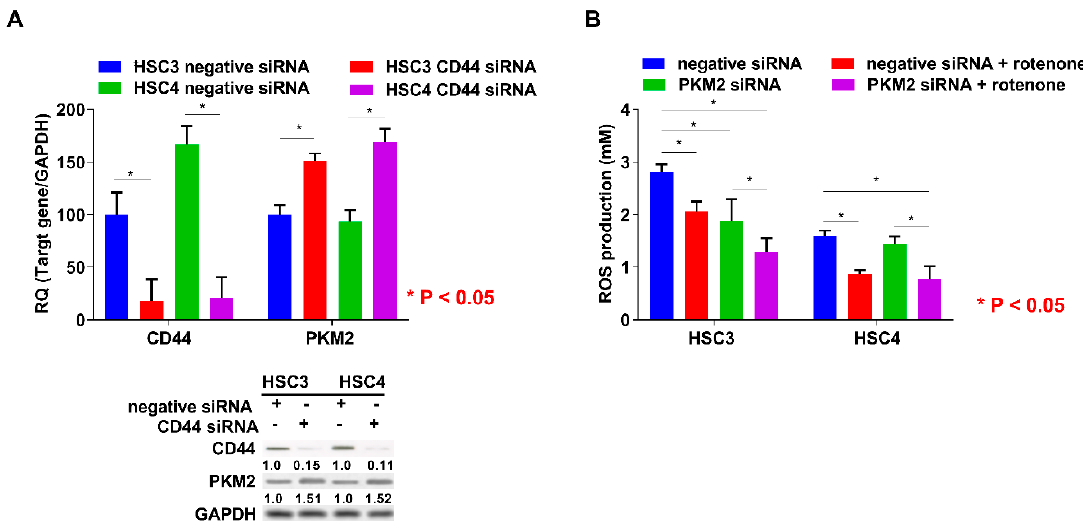
Figure 4. Relationship between PKM2 expression and CD44 knockdown or production of ROS in OSCC cells. ( A ) Effect of negative or CD44 siRNA on CD44, PKM2, and GAPDH expression in HSC3 and HSC4 cells. Numbers below the panels of immunoblotting are the semiquantified protein expression level. ( B ) Effect of PKM2 knockdown on production levels of ROS in HSC3 and HSC4 cells. Error bar: standard deviation. RQ: relative quantification.